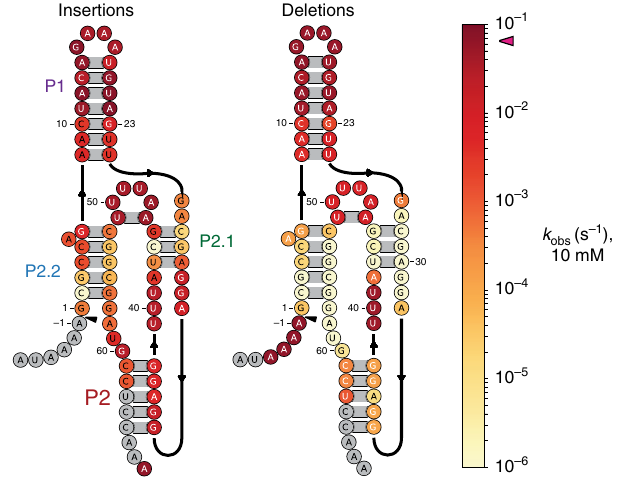
Fig. 3 Catalytic consequences of insertions and deletions. Heatmap of the catalytic rates for double-incorporation insertion and point deletion mutants of the core glmS ribozyme. Source data are available in the Source Data fi